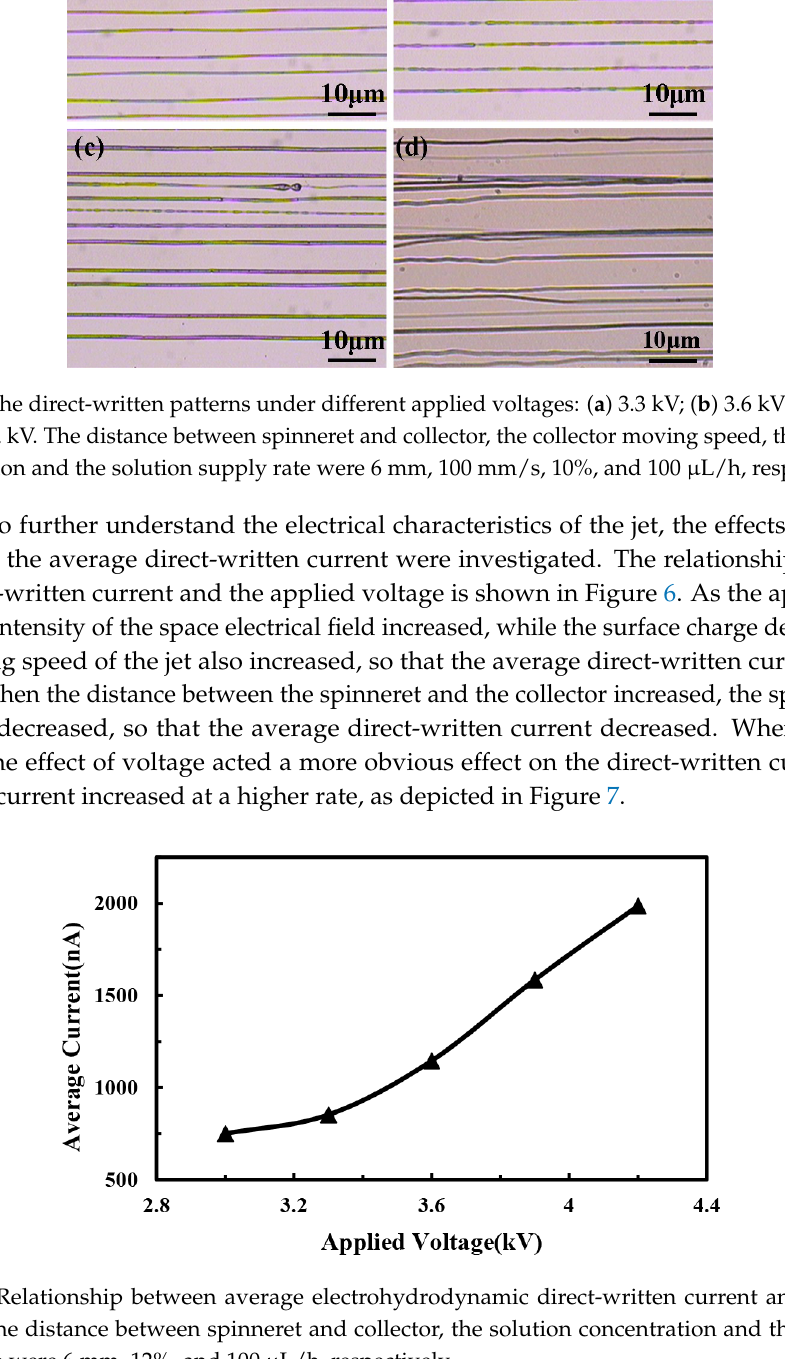
Figure 5. The direct-written patterns under different applied voltages: ( a ) 3.3 kV; ( b ) 3.6 kV; ( c ) 3.9 kV; and, ( d ) 4.2 kV. The distance between spinneret and collector, the collector moving speed, the solution concentration and the solution supply rate were 6 mm, 100 mm/s, 10%, and 100 μL/h, respectively.